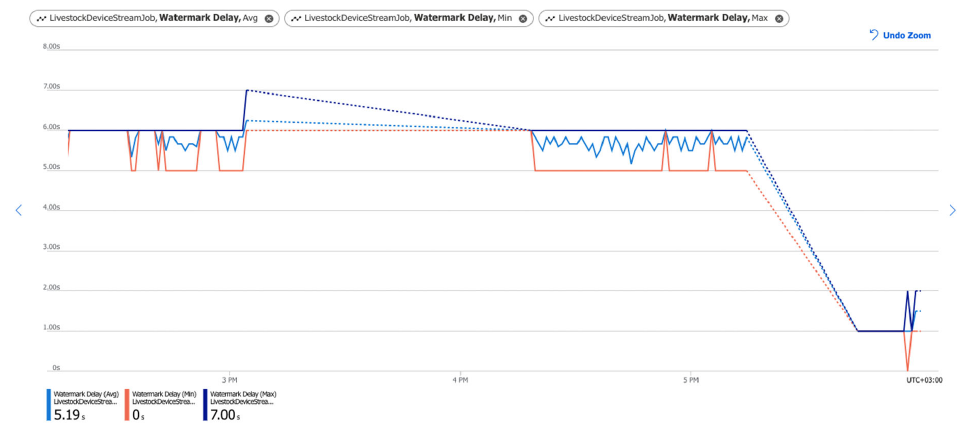
Figure 10. Watermark delay. The blue line shows the average watermark delay. The Red line shows the minimum watermark delay. The dark blue line shows maximum watermark delay. The dotted line shows that no data is ingested for that period (when IoT devices are in sleep mode).